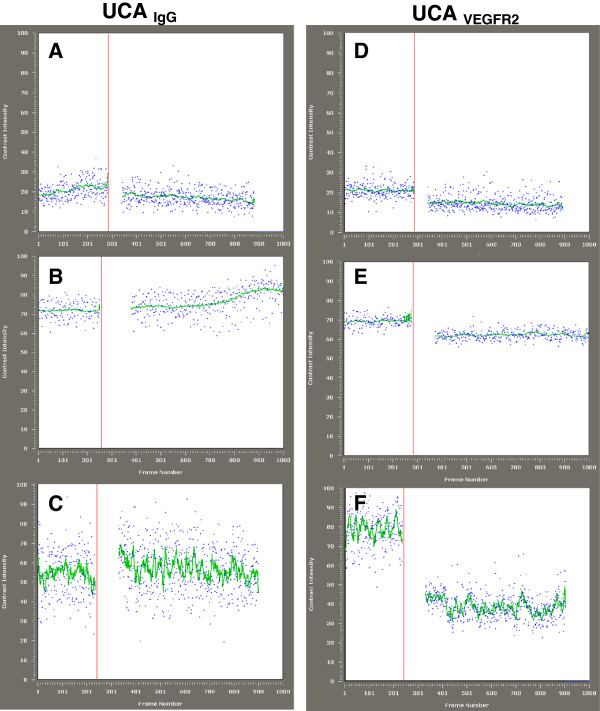
Video intensities curves. Predestruction and postdestruction video intensities curves for the control UCA (A–C) and the VEGFR2-targeted UCA (D–F). The average video intensity of predestruction and postdestruction sonograms was measured and the difference in video intensity between the predestruction and postdestruction ultrasonographic frames was calculated and expressed as video intensity difference (VID). This value provided a relative measure of the amount of targeted microbubbles retained by the tumor. Video Intensities curves of a normal thyroid parenchyma (A,D), adenoma (B,E) and a thyroid tumor (C,F). These images show a significant difference between retention of the control and VEGFR2-targeted UCAs in a thyroid tumor.